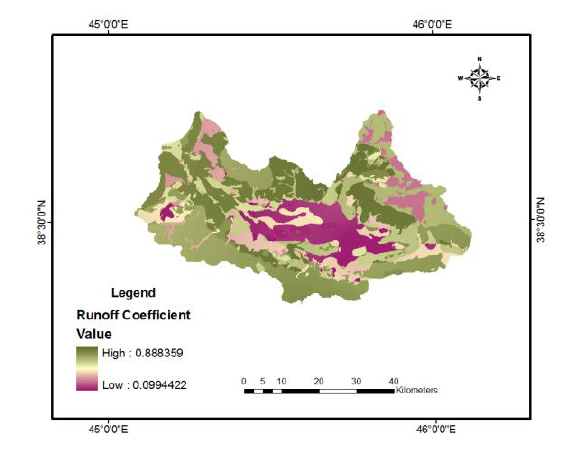
Figure 9. Runoff coefficient map of Zilberchai basin